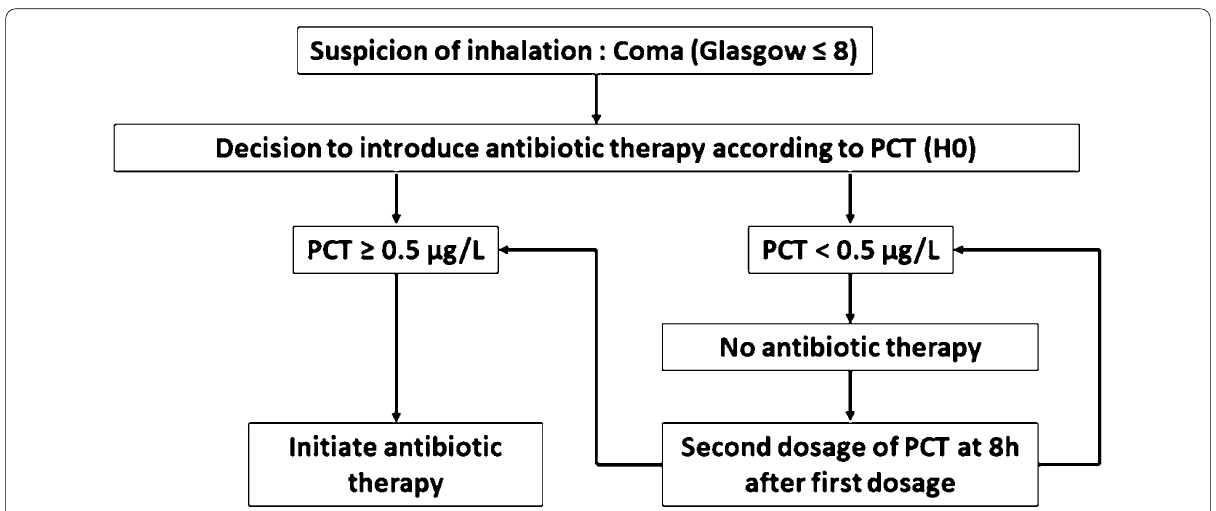
Fig. 1 Decisional algorithm for the initiation of antibiotic therapy at inclusion (H0) and at 8 h after inclusion